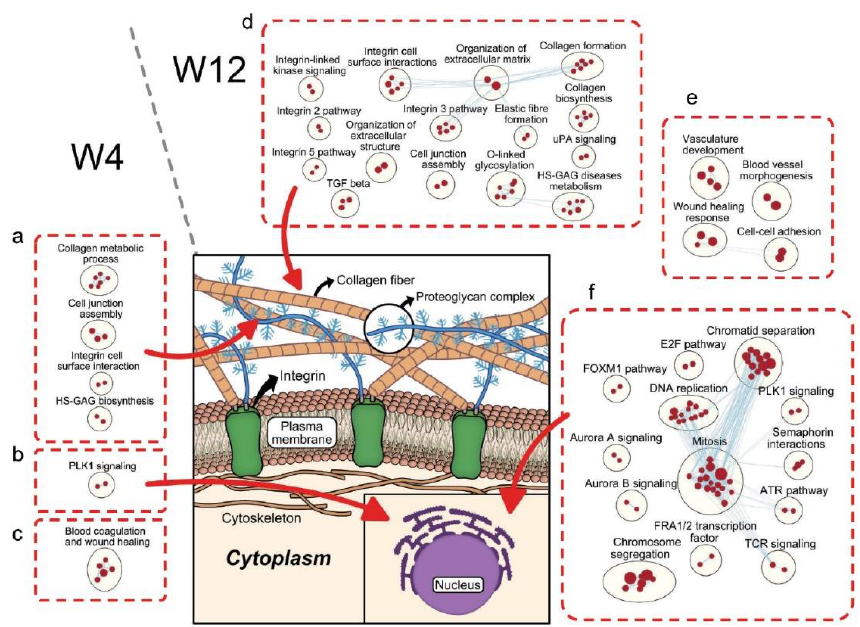
Figure 5. Upregulation of tissue development-related pathways in the thyroid glands of Xb130 − / − mice at W4 and W12. Pathways associated with extracellular matrix at W4 ( a ) and W12 ( d ). Pathways associated with cell cycle regulation at W4 ( b ) and W12 ( f ). Pathways associated with angiogenesis, blood coagulation and wound healing at W4 ( c ) and W12 ( e ). Red nodes represent upregulated gene sets in Xb130 − / − mice.